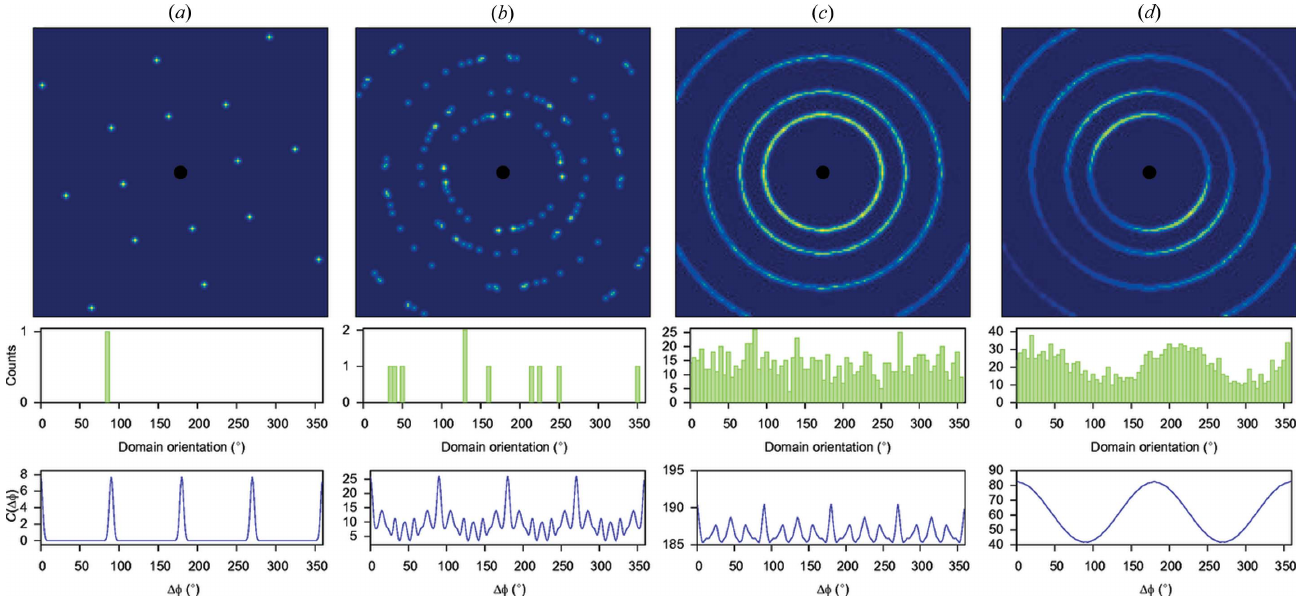
Figure 1 A schematic showing varied X-ray scattering regimes illustrating the effect of crystallite number and pole distribution in each of the following cases: ( a ) a perfect single crystal; ( b ) a small number ( N c = 10) of domains with uniform pole distribution; ( c ) a large number ( N c = 1000) of domains, again with uniform pole distribution; and ( d ) N c = 1000 with anisotropic pole distribution. (Bottom) Histograms indicating the domain orientations and angular correlation functions [ C ( (cid:4) (cid:2) )] calculated for the first diffraction ring for the different types of scattering